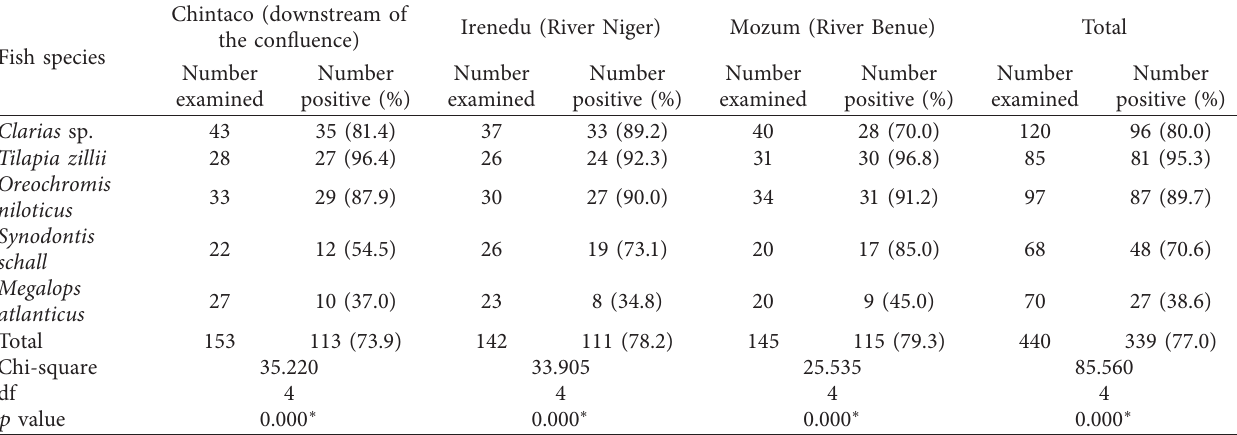
Table 7: Comparison of prevalence of parasites from different locations at rivers Niger and Benue, Lokoja. Fish